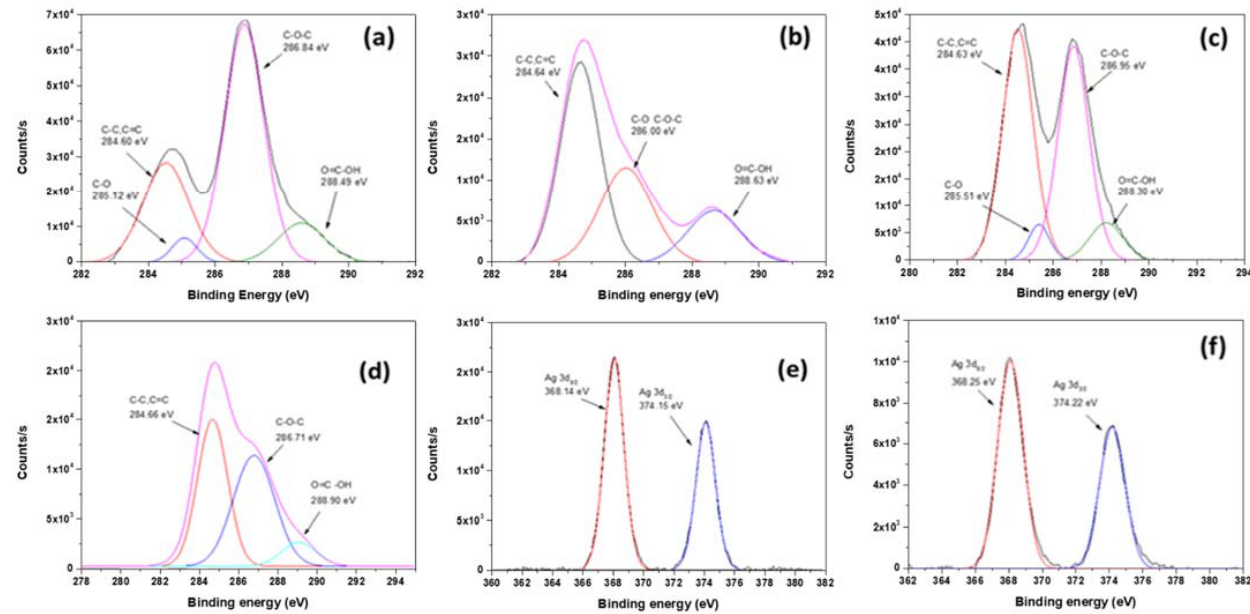
Figure 5. C1s XPS spectra deconvolution of ( a ) GO; ( b ) GOCOOH; ( c ) GO-Ag; ( d ) GOCOOH-Ag; and ( e ) XPS patterns of Ag3d spectra for GO-Ag and ( f )